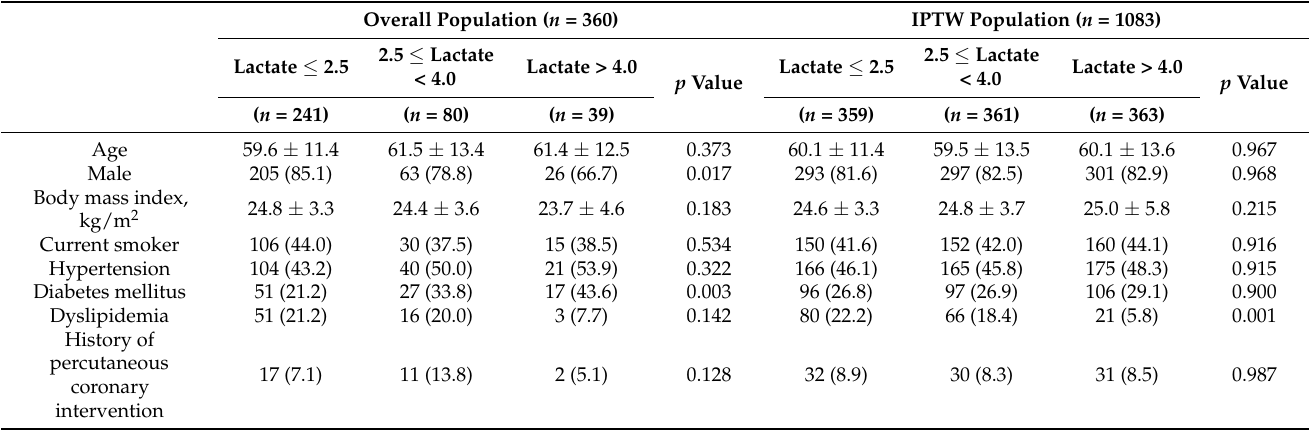
Table A1. Baseline characteristics according to serum lactate levels